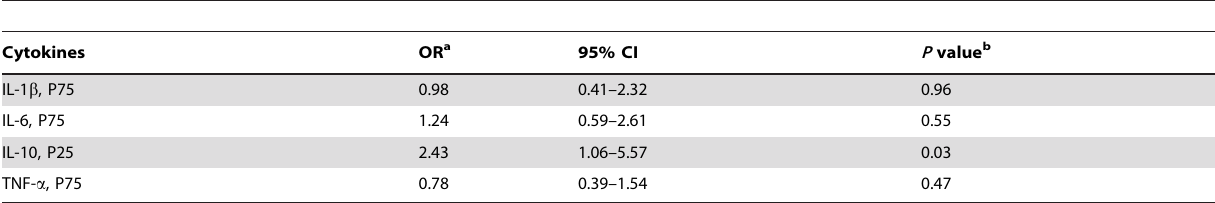
Table 4. Association between cytokines values (in quartiles) and the presence or absence of metabolic syndrome in postmenopausal women.